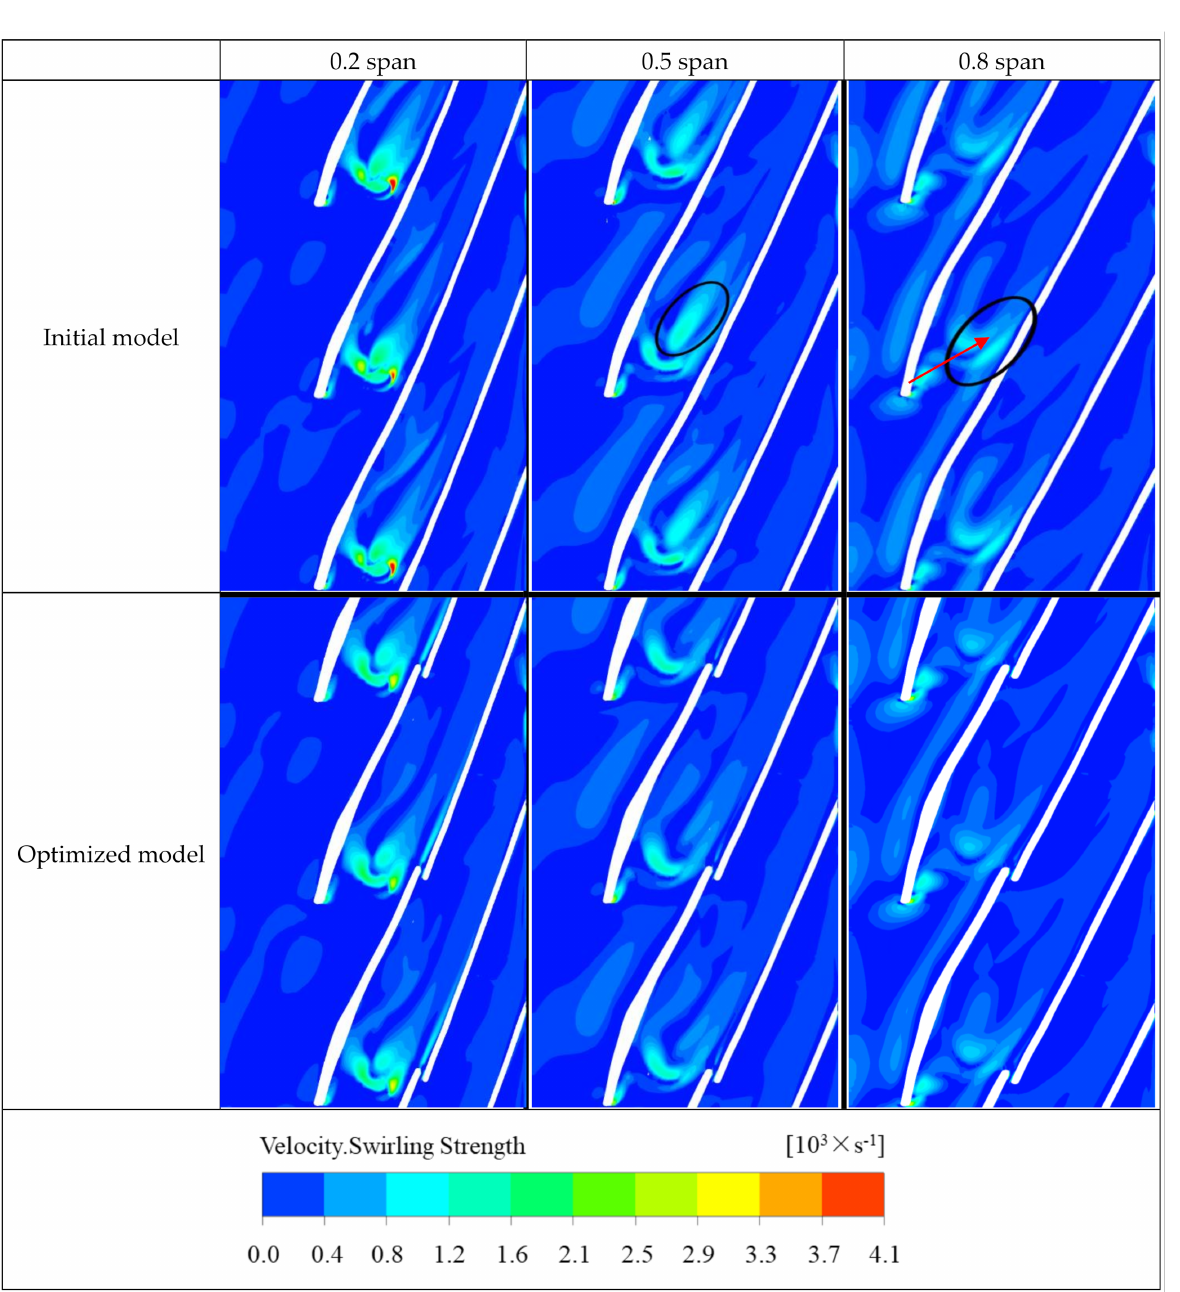
Figure 9. Distribution of velocity. Swirling strength within the initial and optimized